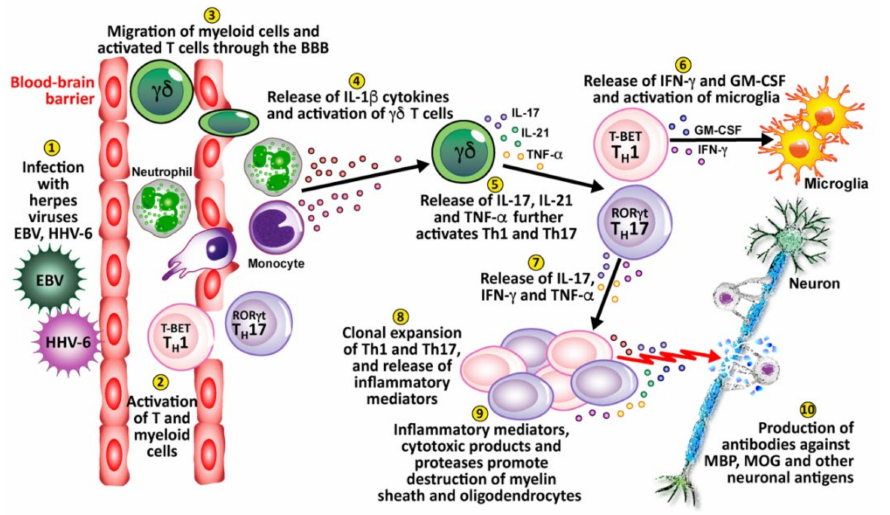
Figure 10. 10 key pathological processes induced by the herpes family of viruses that results in the destruction of neurons and the production of antibodies against MBP, MOG, and other neuronal